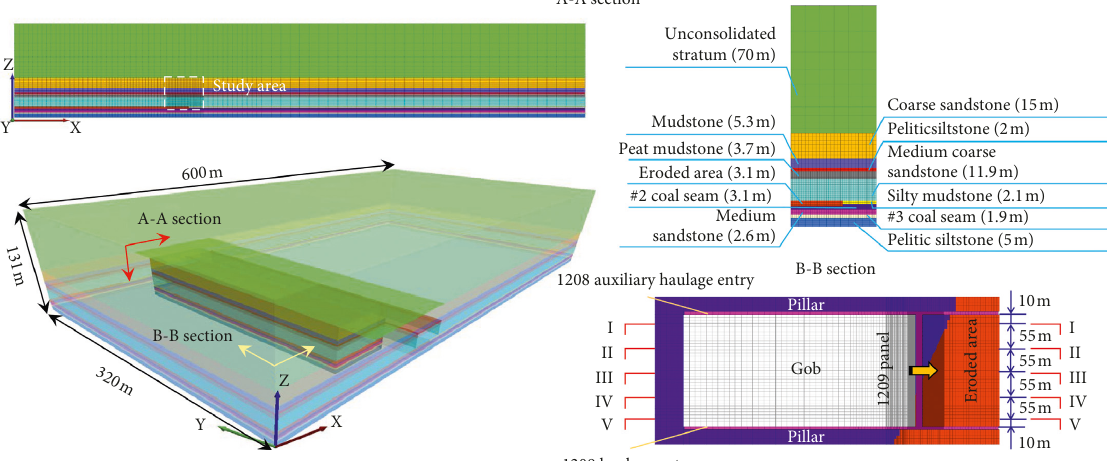
Figure 10: Numerical model of the working